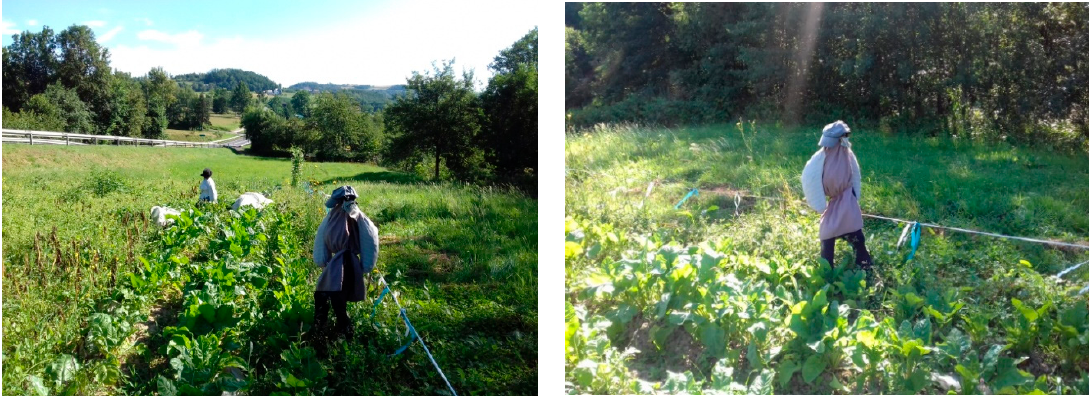
Figure 1. Scarecrows, a ‘farmer’ and his ‘wife’ guarding a small vegetable patch. Near Grybów (Małopolskie Voivodeship). Source: author.